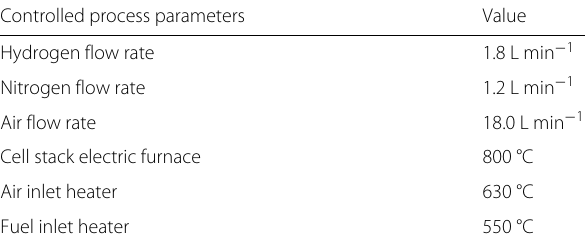
Table 1 The long-term operation experiment conditions Controlled process